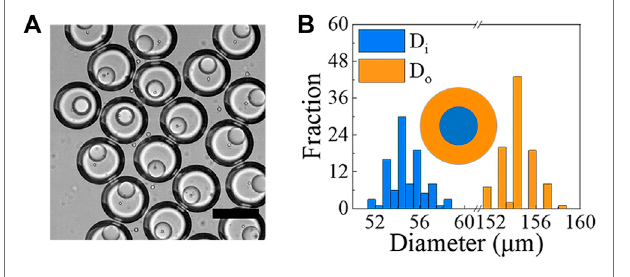
FIGURE 7 | (A) Optical image showing examples of o/w/o droplets generated using micro fl uidic devices. Core phase is mineral oil with 1% span 80,whileshellphaseis10%PVAinPBSandouterphaseismineraloilwith4% span 80.Scale bar represents 150 μ m. (B) Sizemeasurements ofo/w/o droplets generated under the conditions of Q i = 30 μ L/h, Q m = 500 μ L/h and Q o = 1,500 μ L/h (N ≥ 100).